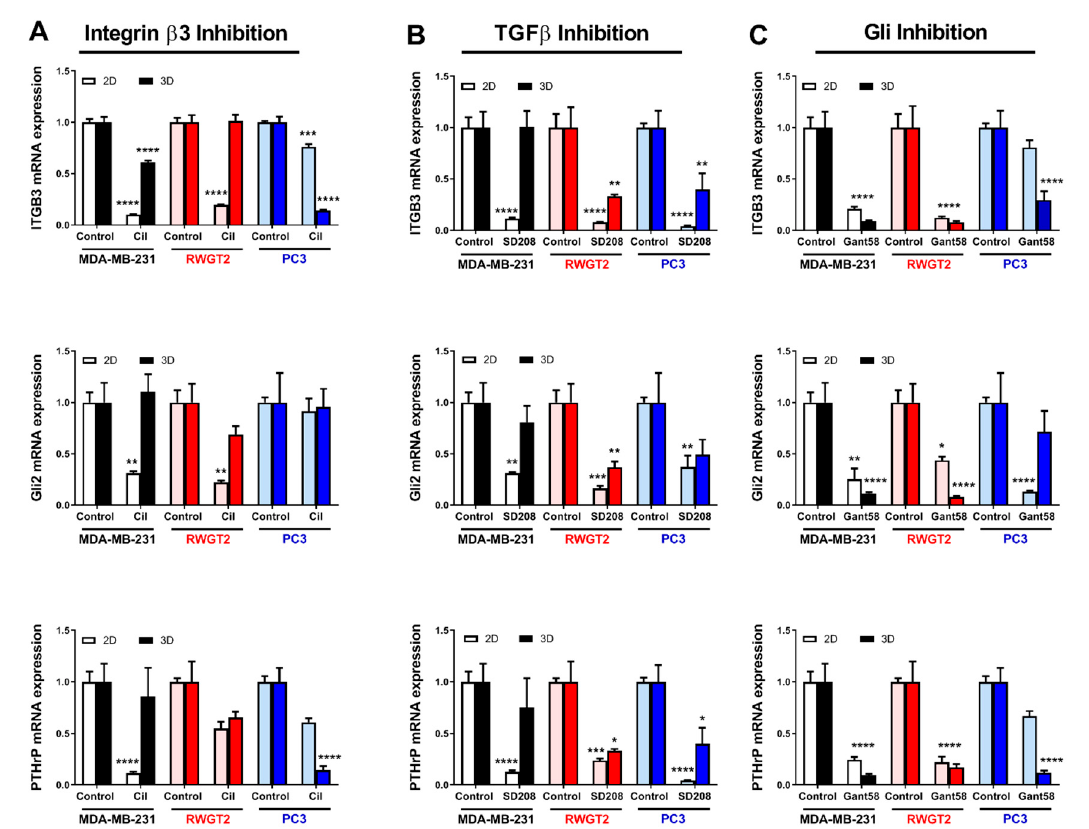
Figure 4. E ff ects of 3D culture on tumor cell drug response. E ff ects of 3D culture on inhibition of MDA-MB-231 (white—2D sca ff olds, black—3D sca ff olds), RWGT2 (pink—2D sca ff olds, red—3D sca ff olds), and PC3 (light blue—2D sca ff olds, dark blue—3D sca ff olds) tumor cells was tested for ( A ) Integrin β 3 inhibition using the inhibitor Cilengitide (Cil), ( B ) TGF- β inhibition using an RI kinase inhibitor (SD208), and ( C ) Gli2 inhibition using the Gli antagonist (Gant58). Cells were grown on 2D rigid films (pale bars) or 420R 3D sca ff olds (dark bars) and mRNA expression was analyzed by qRT-PCR after 48 h in culture. ITGB3 , Gli2 , and PTHrP mRNA expression decreased in response to SD208 and Cilengitide treatment in 2D films, but to a lesser extent in 3D sca ff olds. Gli inhibition was e ff ective in both 2D and 3D and all three tumor cell lines. Data presented as fold change over untreated control. Two-way ANOVA. 3D sca ff olds / 2D sca ff olds treatment vs. control, * p < 0.05, ** p < 0.01, *** p < 0.001, **** p < 0.0001.